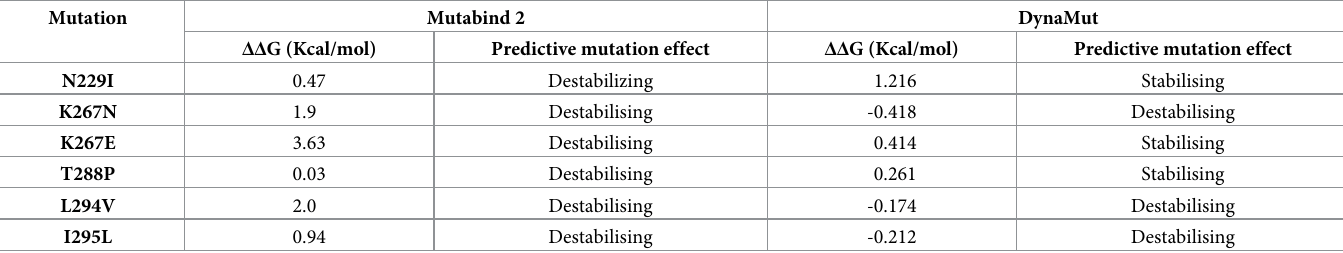
Table 5. Assessment of the effect of human DPP4 mutations identified among the population study on protein-protein interaction (PPI) using computational pre- diction tools Mutabind2 and DynaMut. Mutation